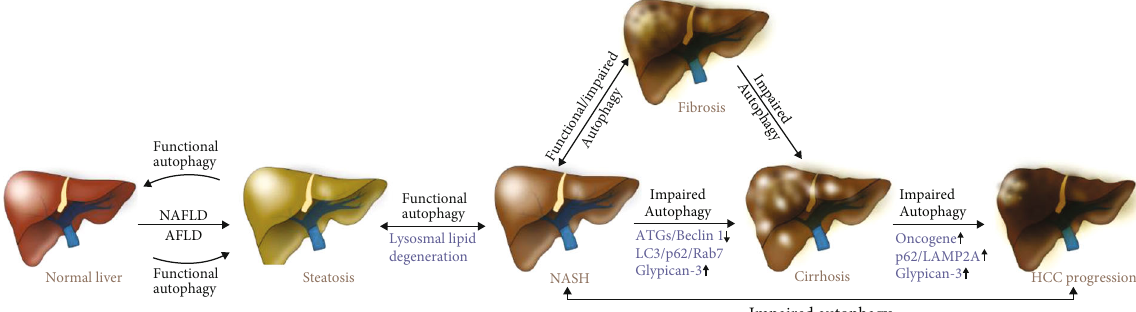
Figure 4: Schematic model represents the role of functional and impaired autophagy in the modulation of NAFLD, AFLD, and HCC. Functional autophagy can reverse hepatic steatosis, NASH, or hepatitis by the degradation of lipid droplets in the initial stages of NAFLD and acute AFLD. When a functional autophagic process is unable to process the overloaded-lipid content in the liver, particularly in chronic NAFLD and AFLD, defective autophagy exists. Due to defective/impaired autophagic function (increasing expression of p62, LC3, Rab7, and Glypican-3), NASH progresses to fi brosis/cirrhosis and subsequently to